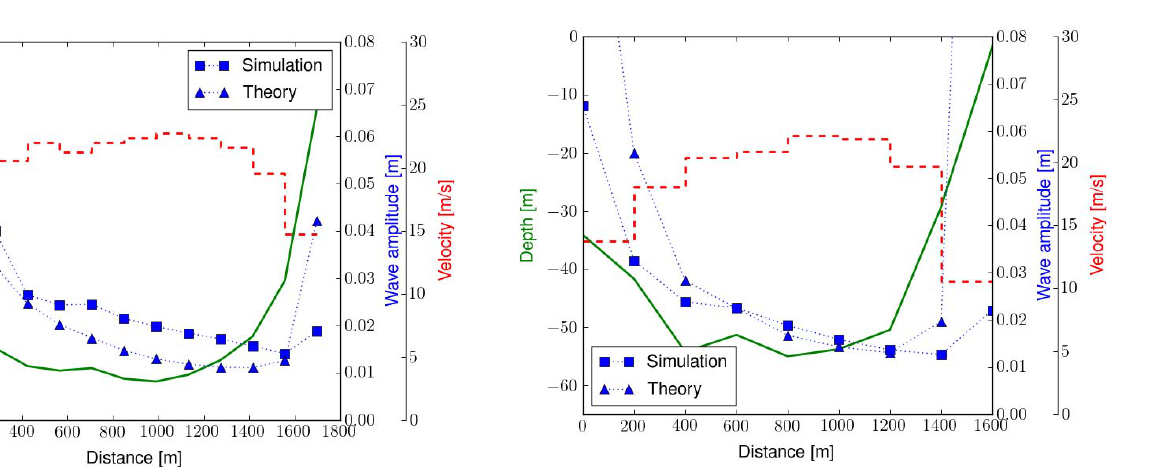
Fig. 6b. Wave propagation in south-west direction.